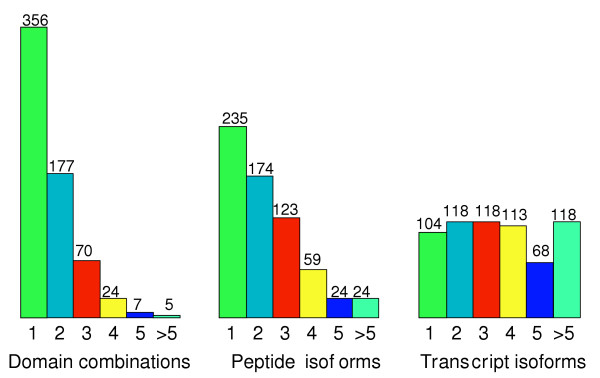
Relationship between transcript isoforms, peptide isoforms, and domain combinations.